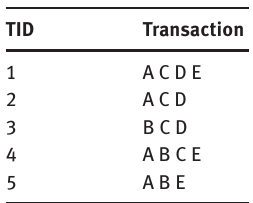
Table 1: Example Transactional